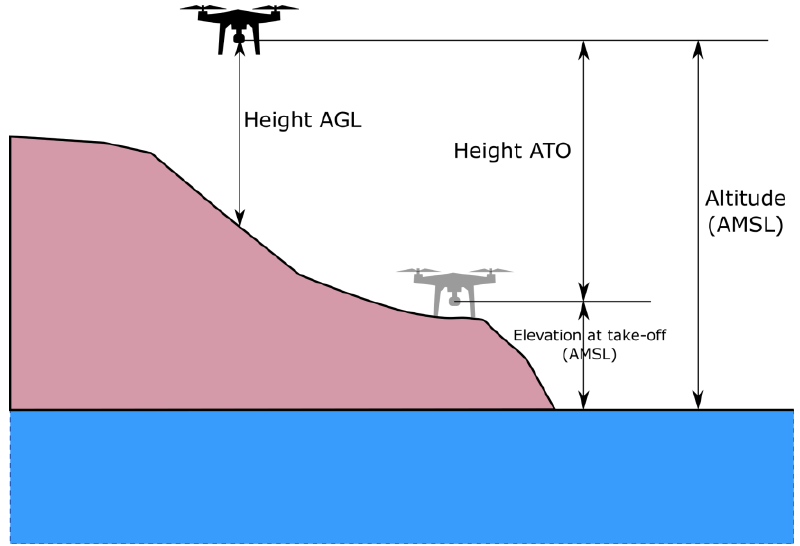
Figure 1. Unmanned aerial vehicle (UAV) heights, elevation and altitude. UAV's take-off point is colored grey and the current UAV position is black.